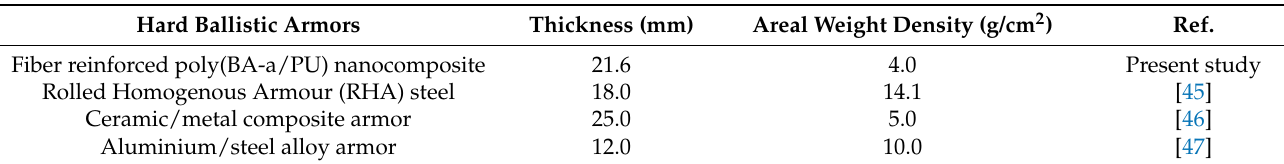
Figure 12. Plot of impact velocity versus impact number used to determine the ballistic limit velocity after being impacted by a 7.62 × 51 mm 2 projectile. Table 4. Comparison on thickness and areal weight density of our fiber reinforced poly(BA-a/PU) nanocomposite and other hard ballistic